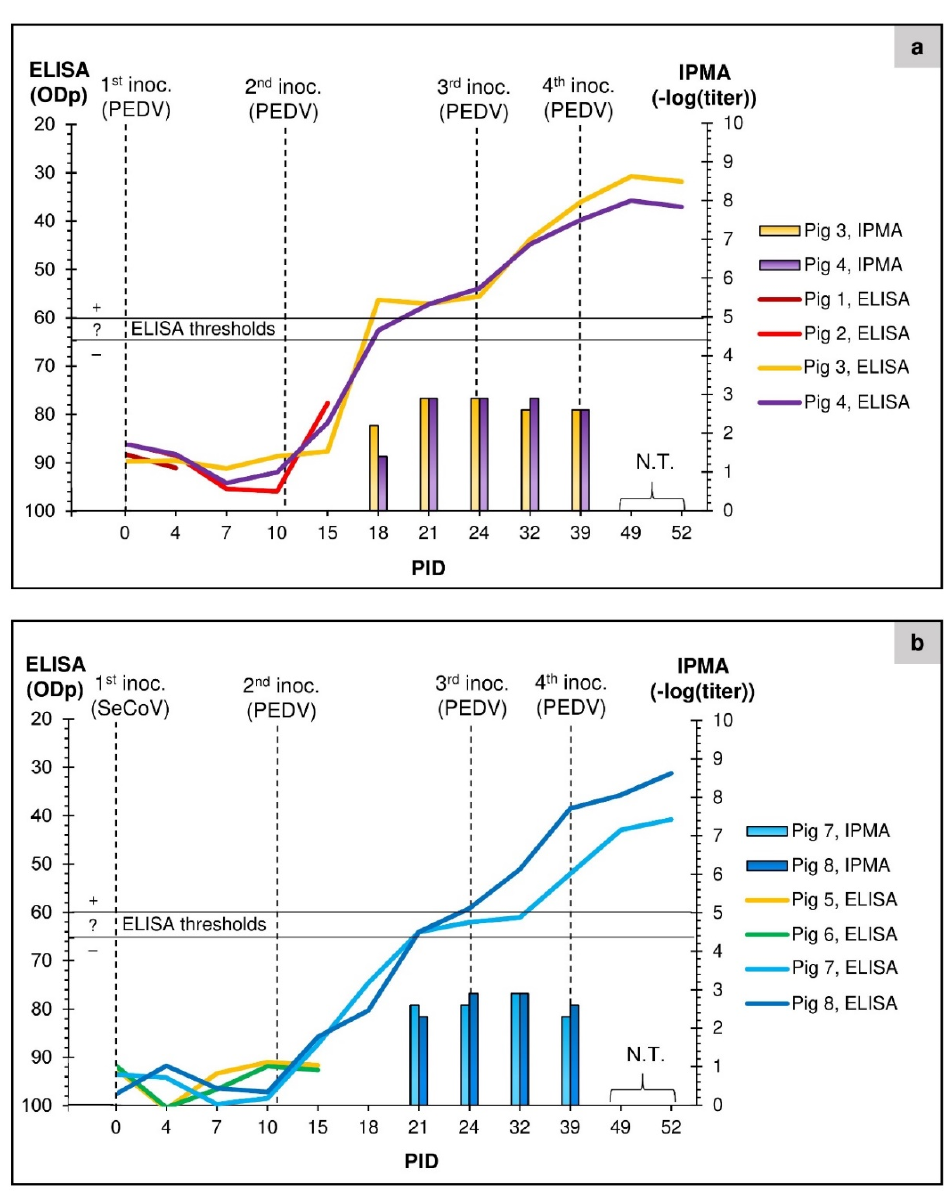
Figure 2. Seroconversion of pigs in group 1 (panel ( a )) and group 2 (panel ( b )) against PEDV. The average ELISA absorbance percentage (ODp) values from testing of serum samples collected on the pre-selected days indicated on the x-axis are shown. The ELISA threshold range of ODp values from 65 to 60 was defined as inconclusive, and values below 60 were considered positive. The columns show the negative log 10 titers, defined as the highest dilution of serum that gave a positive result in the IPMA. The IPMA was performed on sera from all the indicated days except PID 49 and 52 (not tested, N.T.).